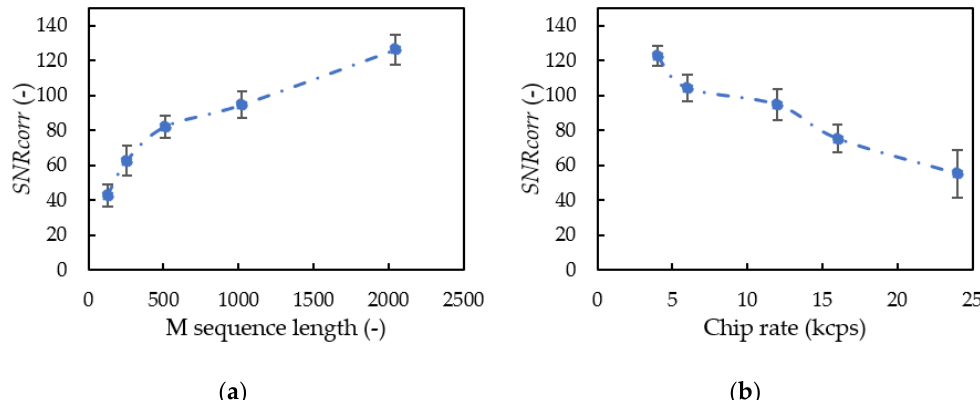
Figure 9. Noise tolerance change with M sequence length ( a ) and chip rate ( b ).